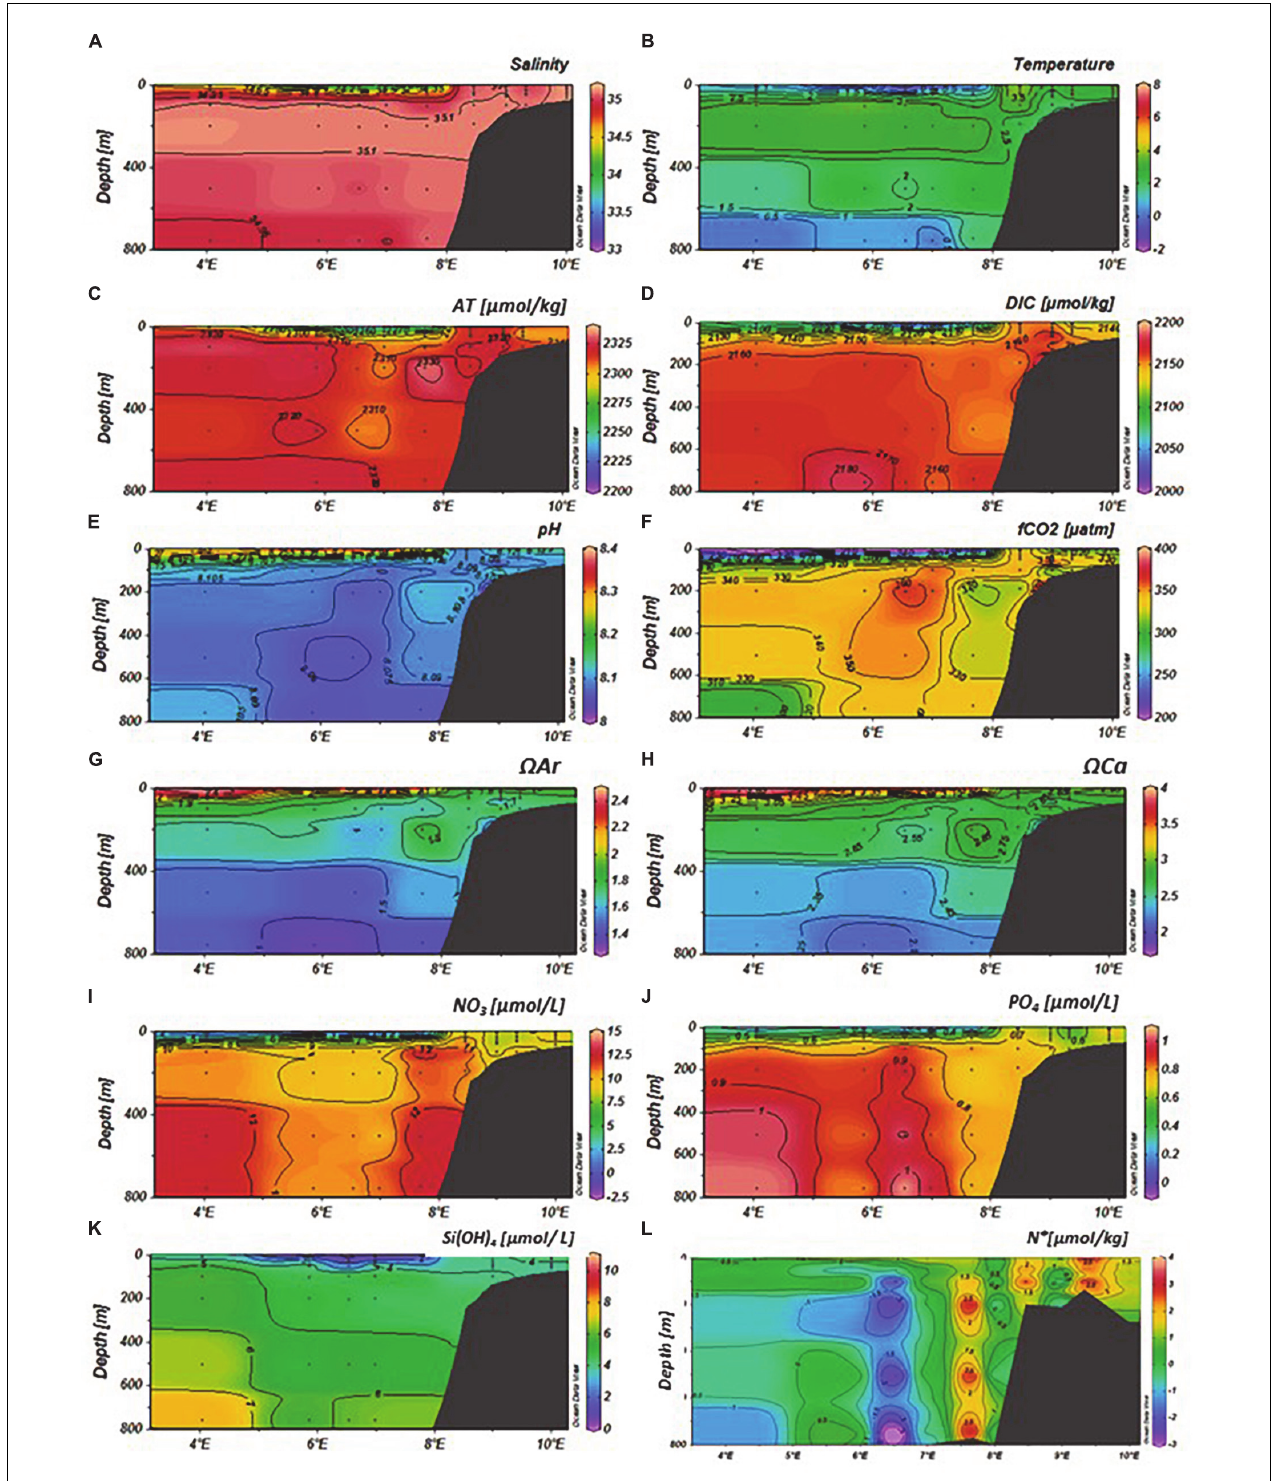
FIGURE 5 | Variability of physical and chemical parameters in the eastern Fram Strait (latitude: 79–79.5 ◦ N, longitude: 4–10 ◦ E) in May 2014 from top; (A) salinity, (B) temperature ( ◦ C), (C) total alkalinity (AT, µ mol kg − 1 ), (D) total dissolved inorganic carbon (DIC, µ mol kg − 1 ), (E) pH, (F) fugacity of carbon dioxide ( f CO 2 , µ atm), (G) aragonite saturation ( (cid:127) Ar), (H) calcite saturation ( (cid:127) Ca), (I) nitrate (NO 3 , µ mol L − 1 ), (J) phosphate (PO 4 , µ mol L − 1 ), (K) silicic acid (SiOH 4 , µ mol L − 1 ), and (L) N ∗ ( µ mol kg − 1 , negative values denote denitrification, and positive values show nitrification). The sampling locations and depths are denoted as black dots. The section plot and interpolation were performed by the Ocean Data View program (Schlitzer,